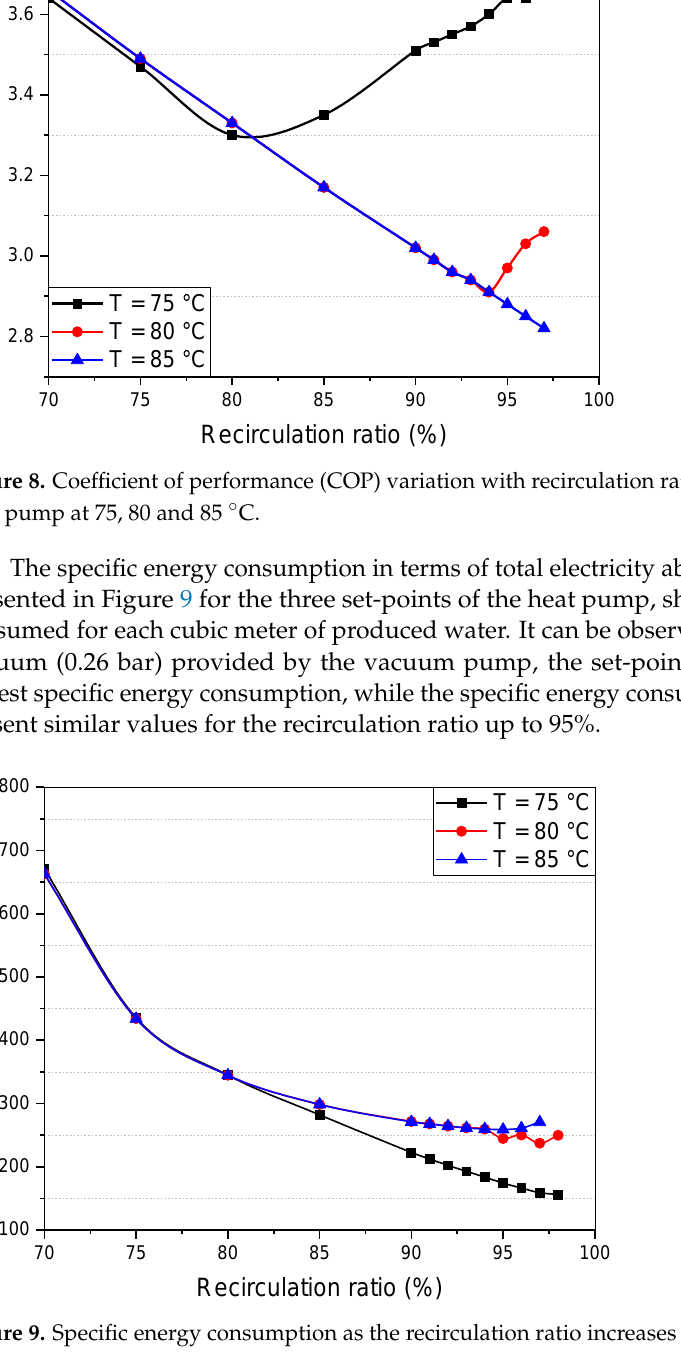
Figure 7. Vacuum pump (VP), heat pump (HP) and total power consumption as recirculation ratio increases for the set-points of 75, 80 and 85 °C.